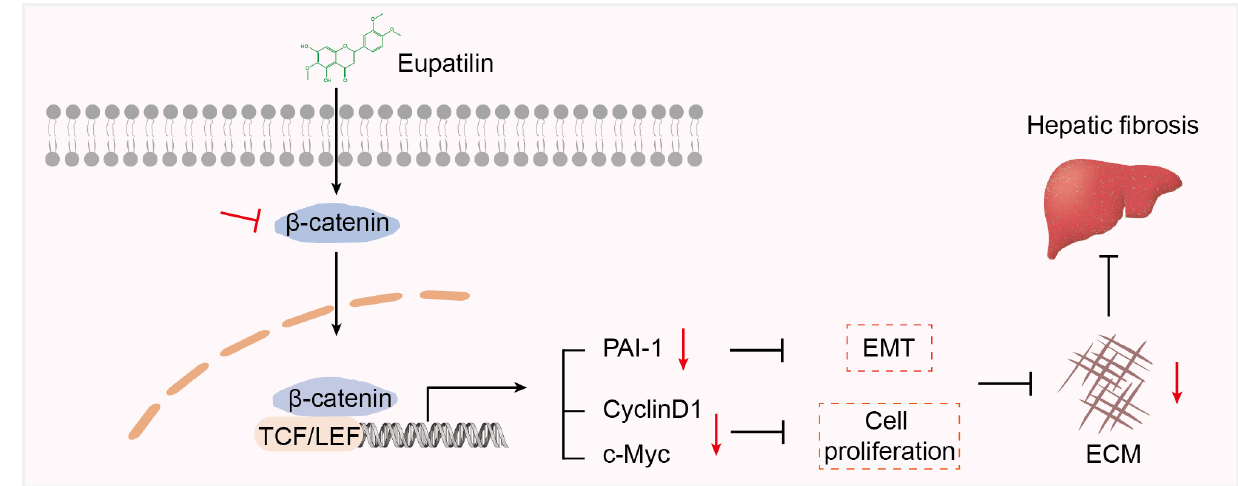
Figure 8. Schematic diagram of the anti-fibrotic effect of eupatilin. Eupatilin inhibits HSC activation by inhibiting EMT process and cell proliferation via suppressing the expression of β -catenin and its downstream targets. Subsequently, inhibition of HSC activation leads to the reduction of the ECM and amelioration of hepatic fibrosis. Red arrows represent decreased expression. Black arrows represent the direction of signal transduction. Red and black blocked lines represent inhibition.